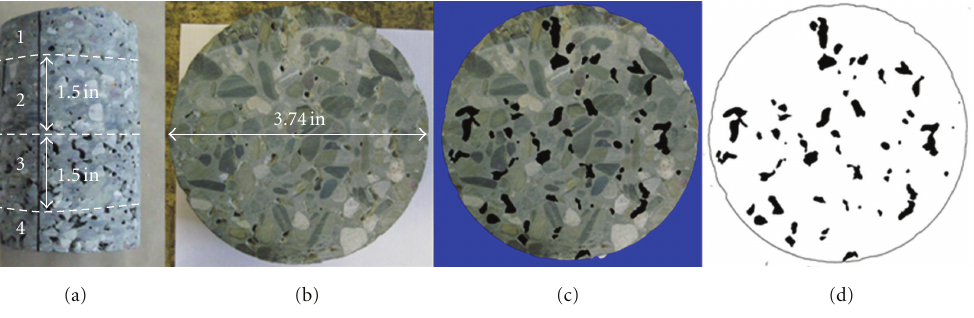
Figure 5: Image analysis of pervious core A-3 (porosity = 7.4%).